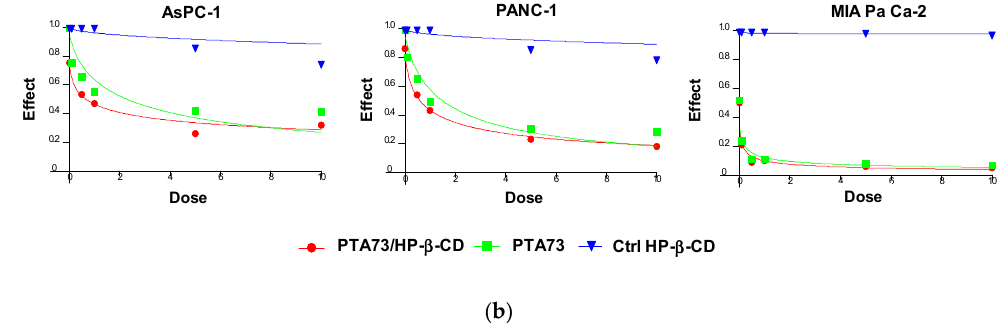
Figure 5. Dose/effect plots of the mean of three different cell proliferation experiments, conducted in PDAC cell lines incubated for 72 h with HP- β -CD (Ctrl HP- β -CD), PTA34, and PTA34/HP- β -CD (panel ( a )) or with HP- β -CD (Ctrl HP- β -CD, PTA73, and PTA73/HP- β -CD (Panel ( b )). Dose was expressed in each graph as 0.01–10 µM concentration range, in terms of PTA34 or PTA73, corresponding to 2.9–2900 µg/mL concentration range for HP- β -CD alone. Table 2. Inhibitory E ff ect of PTA Compounds and PTA / HP- β -CD Complexes on Pancreatic Ductal Adenocarcinoma (PDAC) Cancer Cells. IC 50 ( µ M ±